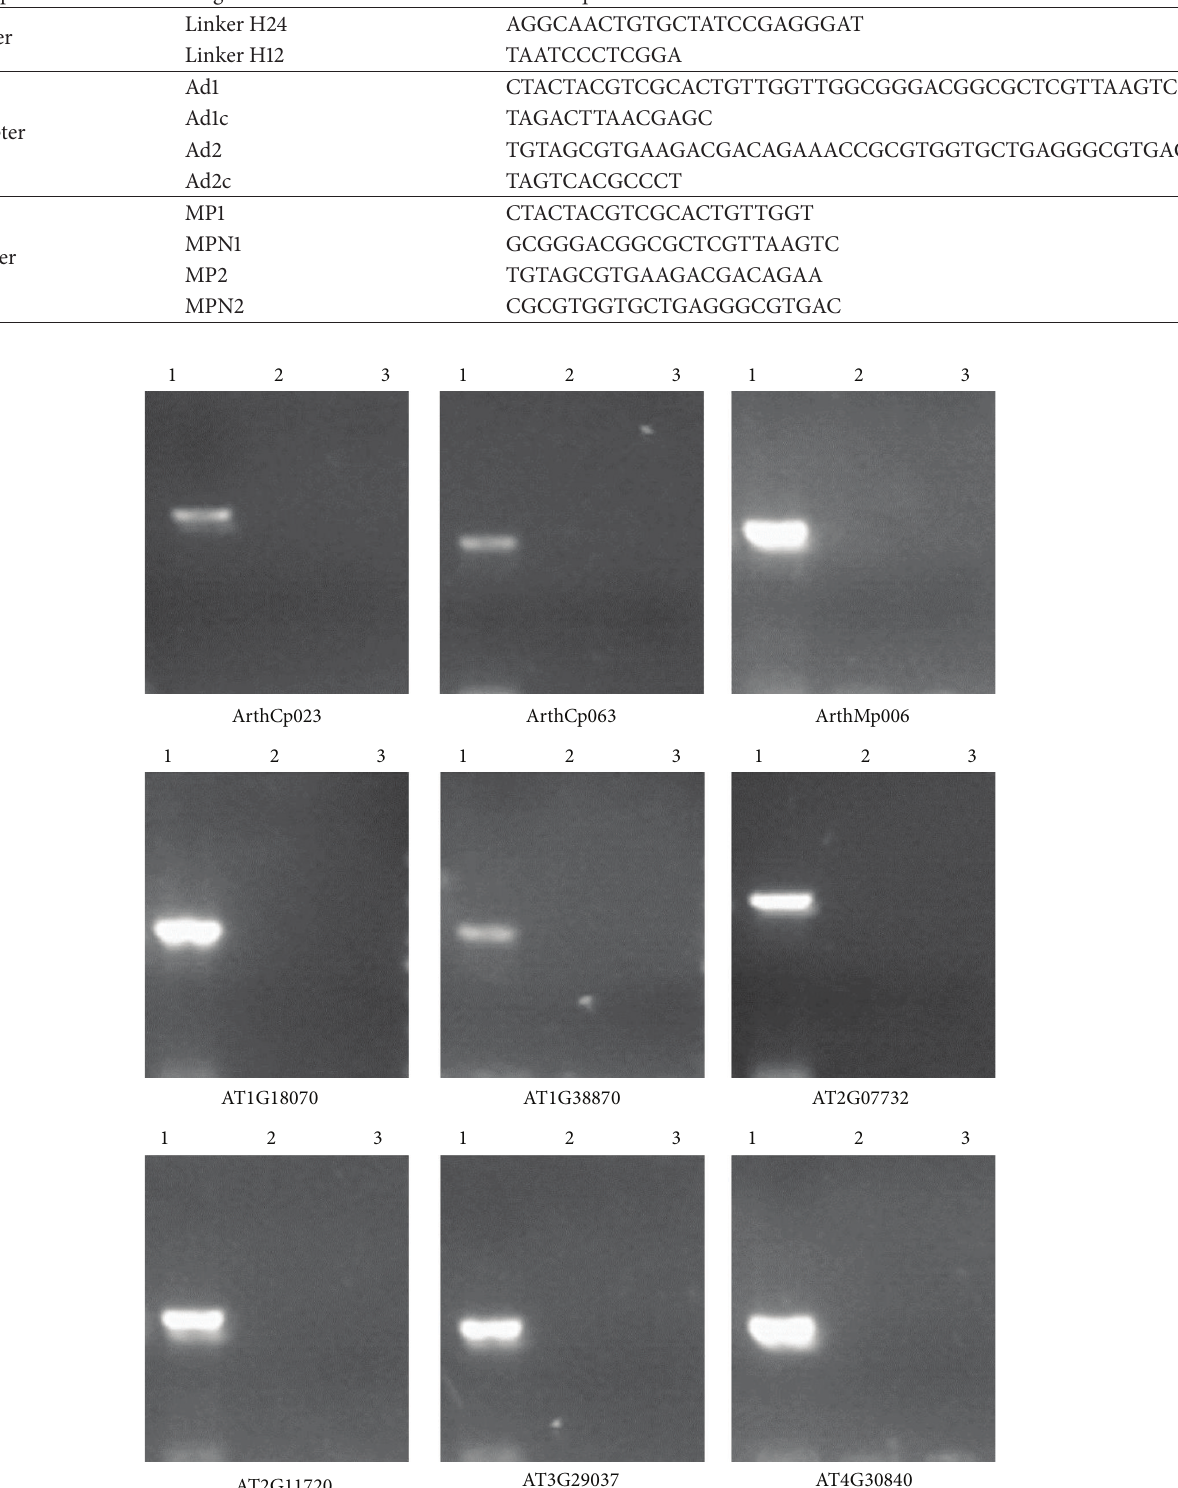
Figure 1: MS-RE PCR results of some genes under different conditions. Genomic DNA extracted from plants treated with cold (4 ∘ C) (Lane 2), 5-Aza (50 𝜇 M) (Lane 3) or normal conditions (Lane 1) were digested with Hha I/Hpa II, then taken PCR